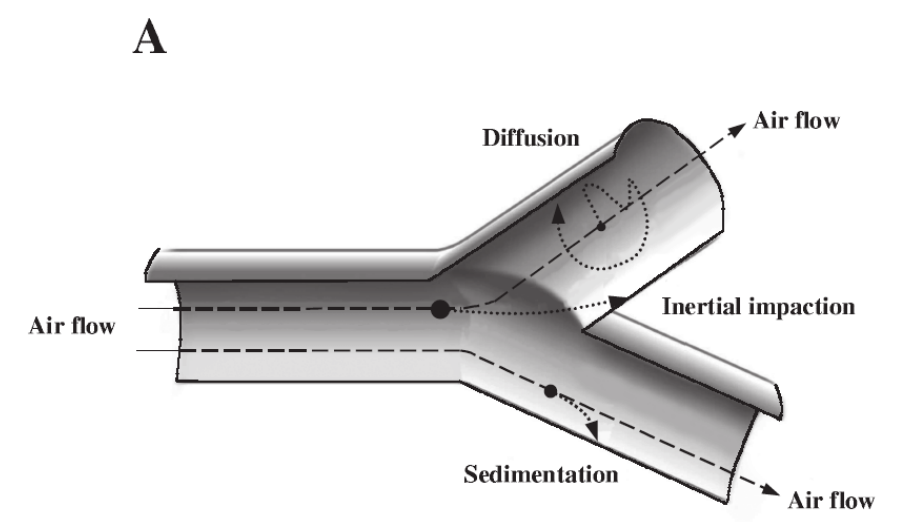
Fig. 2 Mechanisms of particle deposition in the human airways are schematically illustrated. With permission